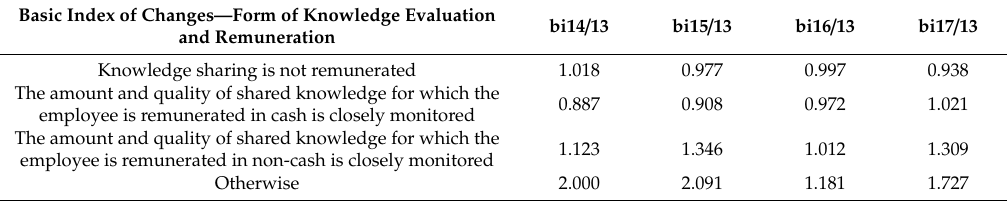
Table 7. Basic index of changes—form of knowledge evaluation and remuneration.